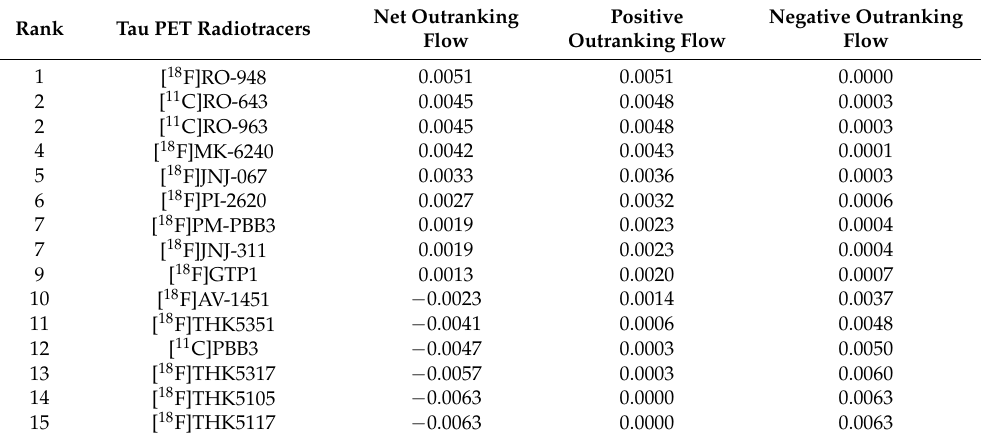
Table 3. Complete ranking of the tau PET radiotracers. Outranking net flow is the difference between positive and negative flows. The higher the outranking net flow, the more preferable the alternative. Net Outranking Positive Negative Outranking Rank Tau PET Radiotracers Flow Outranking Flow Flow 1 [ 18 F]RO-948 0.0051 0.0051 0.0000 2 [ 11 C]RO-643 0.0045 0.0048 0.0003 2 [ 11 C]RO-963 0.0045 0.0048 0.0003 4 [ 18 F]MK-6240 0.0042 0.0043